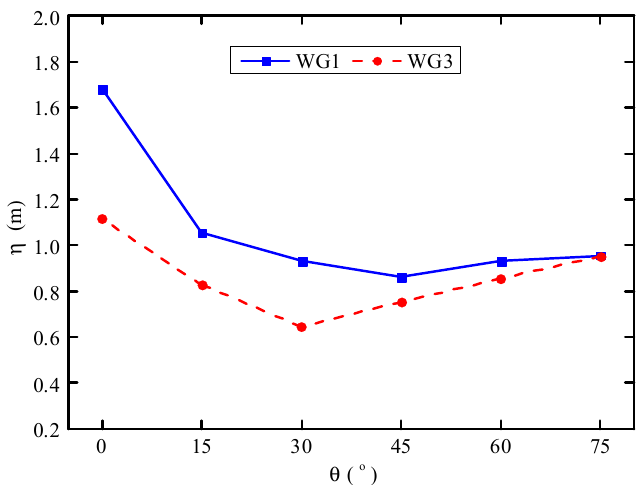
Figure 10. Comparison of the peak values of the free surface elevations around the cylinder with different transverse inclined angles θ .